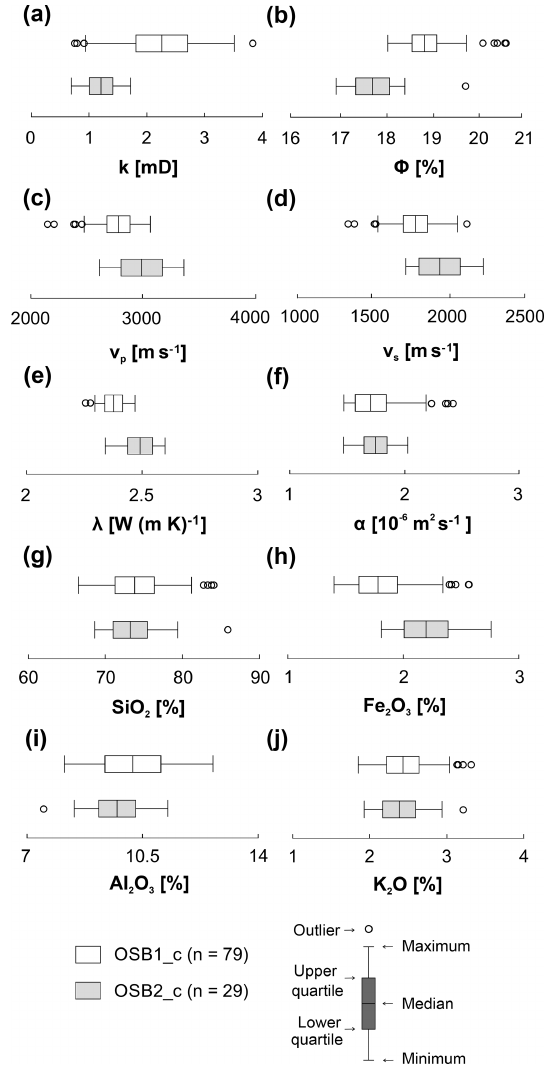
Figure 7. Box and whisker charts showing the empirical distribu- tion of the rock properties measured in the rock cylinders taken from the rock cubes. Outliers were detected according to Tukey’s method (Tukey, 1977), where a value is tested to be in the 1.5 times interquartile range of the arithmetic mean. (a) Intrinsic